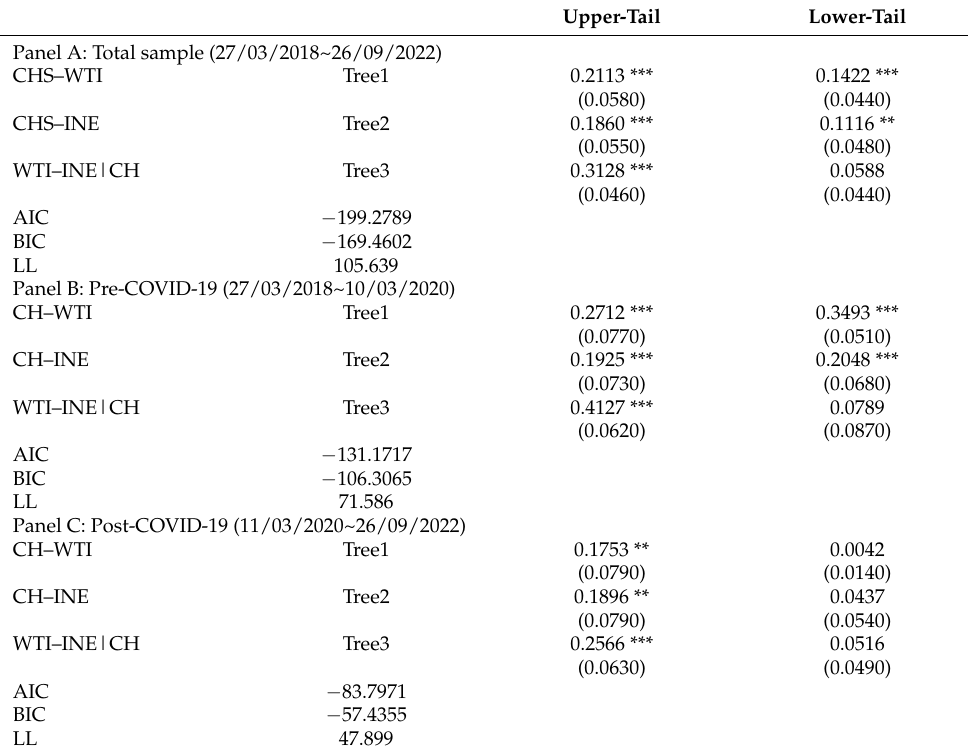
Table 7. Estimation results of the SJC vine Copula